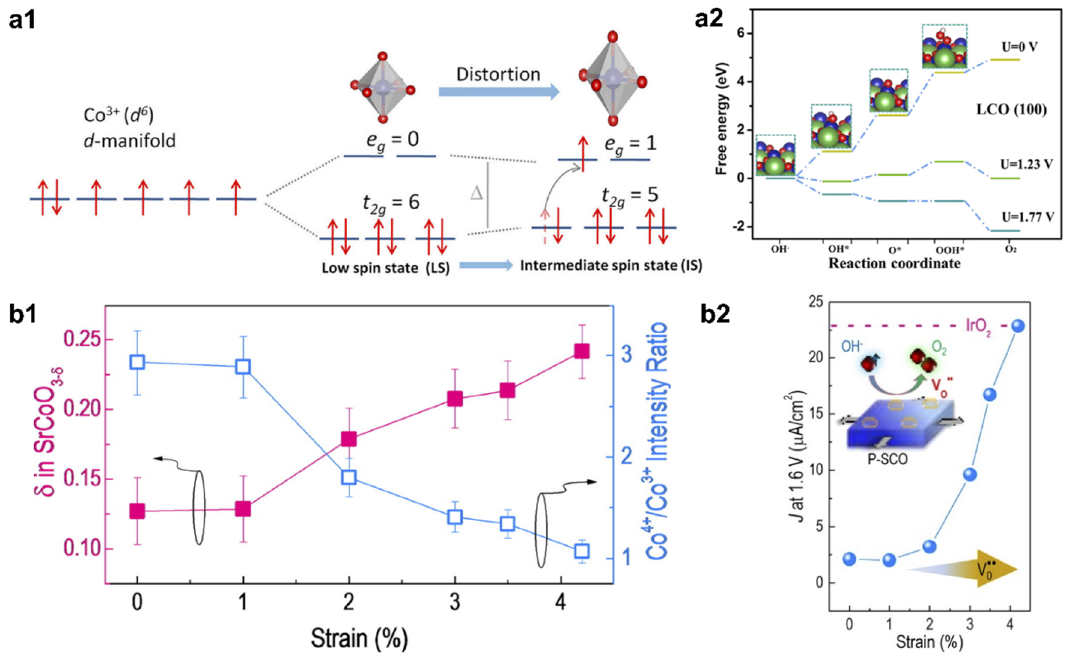
Figure 2. ( a ) Strain-induced distortion of the CoO 6 octahedron in LaCoO 3 optimizes the e g orbital filling and OER activity: ( a1 ) A comparison of the spin states and ( a2 ) the OER free-energy diagrams obtained for the LCO (100) film depending on the reaction coordinates; reproduced with permission [50] Copyright (2017), Elsevier. ( b ) Strain-induced tuning of the oxygen vacancies boosts the OER activity: ( b1 ) the dependence of the number of oxygen vacancies ( δ ) and Co 4 + / Co 3 + ratio in SrCoO 3- δ perovskite on the tensile strain, and ( b2 ) the OER current density observed at 1.6 V vs. reversible hydrogen electrode (RHE) as a function of strain; reproduced with permission [47] Copyright (2016), American Chemical Society.